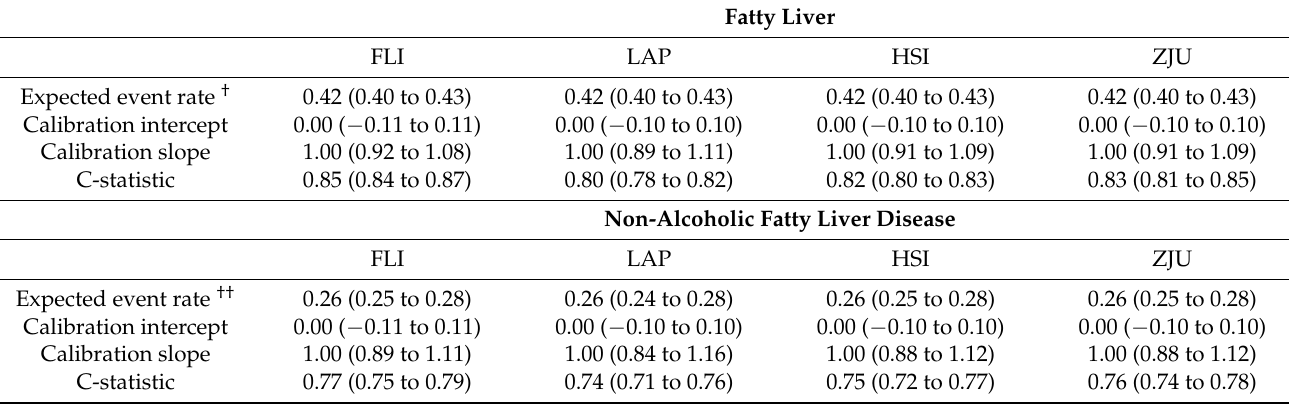
Table 2. Calibration and discrimination of the fatty liver index, lipid accumulation product, hepatic steatosis index and Zhejiang University index at diagnosing fatty liver and non-alcoholic fatty liver disease.